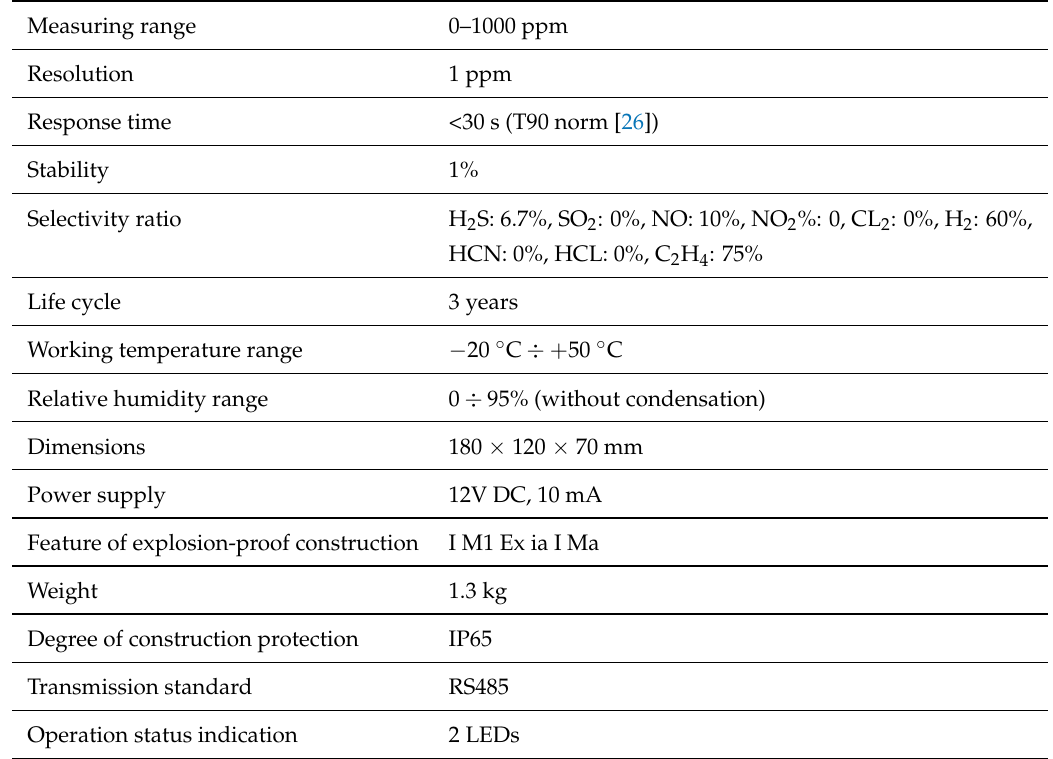
Table 1. Basic technical parameters of the gas sensor of the carbon